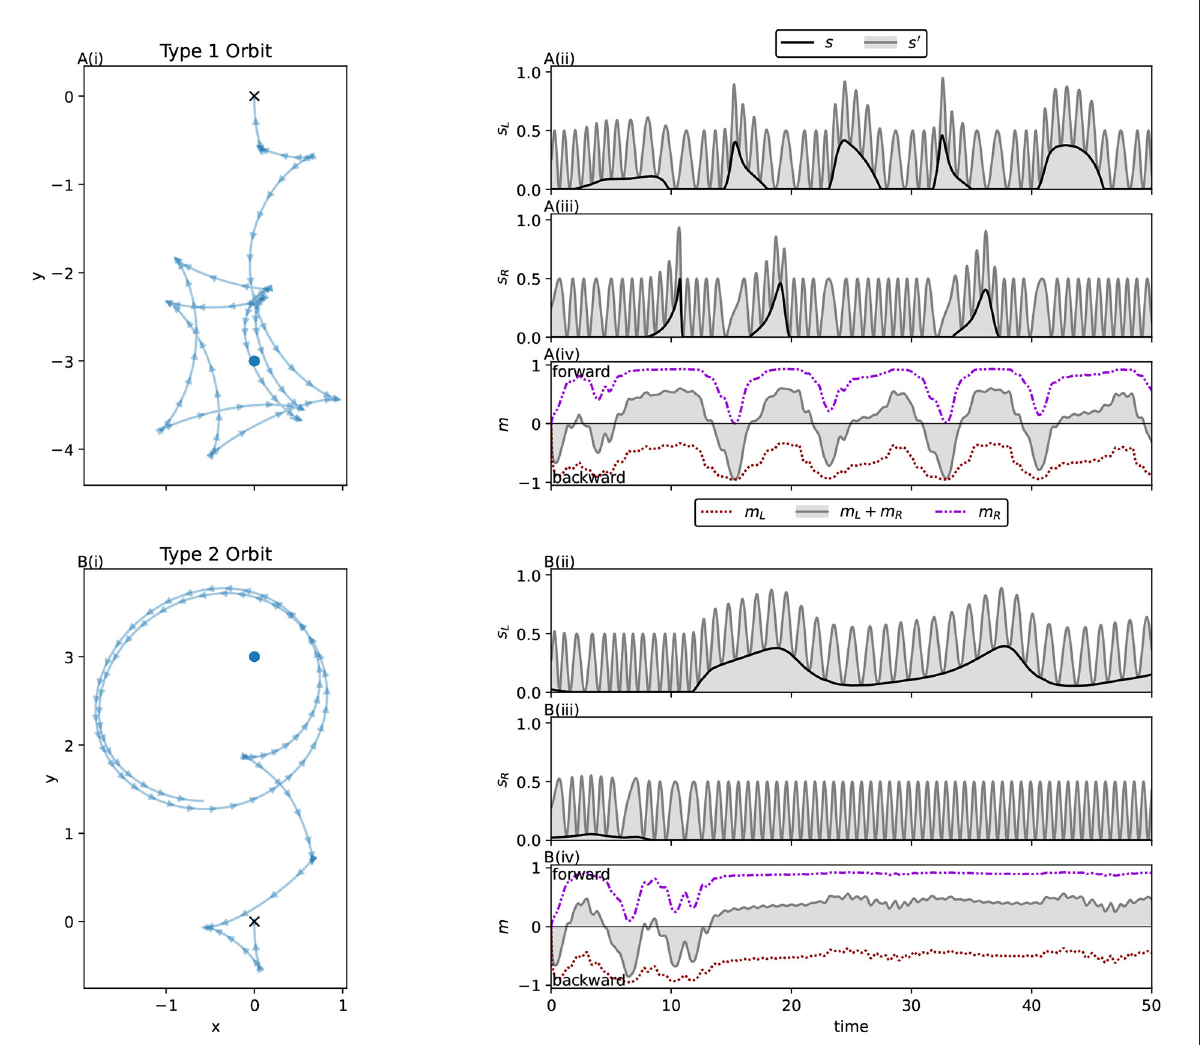
FIGURE14 Spatial trajectories and sensorimotor activity for the solution evolved with squared interference. Subfigures are labeled as in Figure 8. The sensor plots show how the relatively slowly changing environmental sensor stimulation raises the minima of the high frequency interference, allowing the environmental stimulus to be responded to despite the interference. The difference in timescale that makes this possible is clearly visible here. Responsiveness to the environment is most clearly visible in A(iv) , where more positive motor activity is associated with environmental stimulation of the left or right sensor. The continual oscillations in motor activity (most clearly visible in the gray net motor activity line) are driven by the high frequency interference. These oscillations produce the elliptical Type 2 orbit seen in B(i)